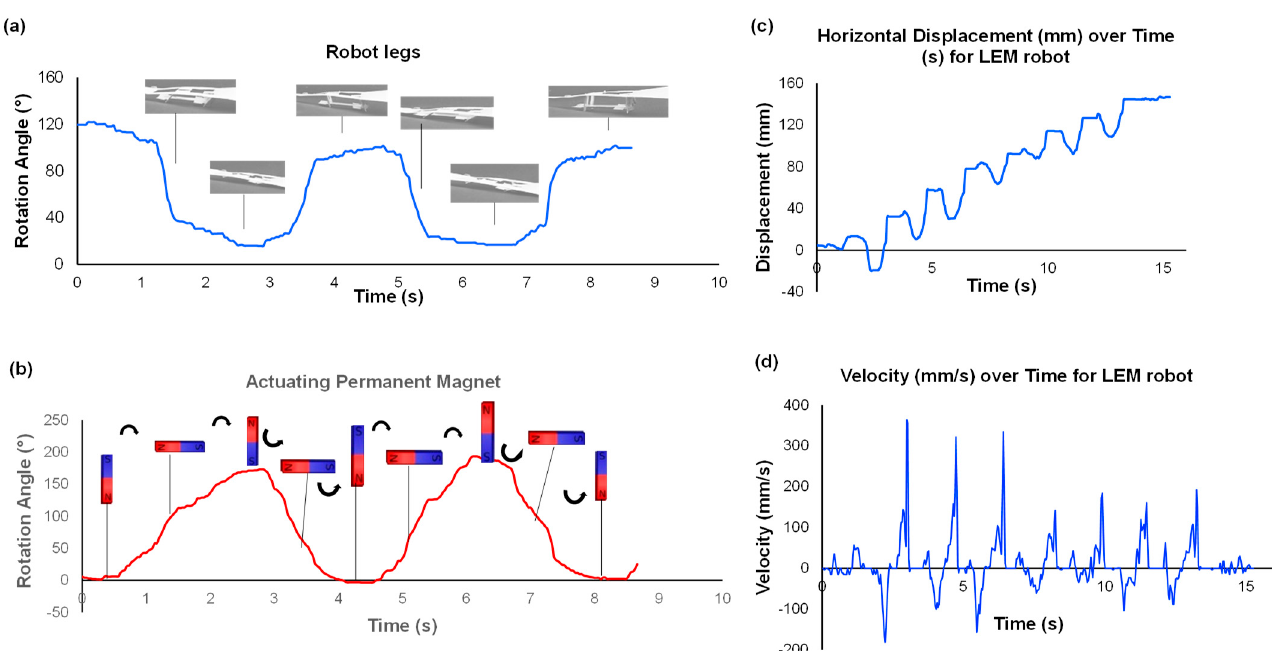
Figure 11. Locomotion of SLEM: ( c ) Graph of displacement ( x -direction) versus time for SLEM at 0.6 Hz, completing 15 cm in 14 s within eight gait cycles. ( a ) Movement of SLEM for one cycle, corresponds with the numbered points. The rotation angle of the SLEM leg is measured with respect to the horizontal planar body (parallel to the traveling surface). ( b ) The rotation angle of the APM is measured with respect to its vertical direction (north pole facing up). The visual representation of the angles is shown in the attached pictures. SLEM legs are vertical when the APM is in their original vertical direction (north pole facing up). ( c ) Graph of displacement of SLEM over time. ( d ) Graph of the velocity of the SLEM ( x -direction) over time.